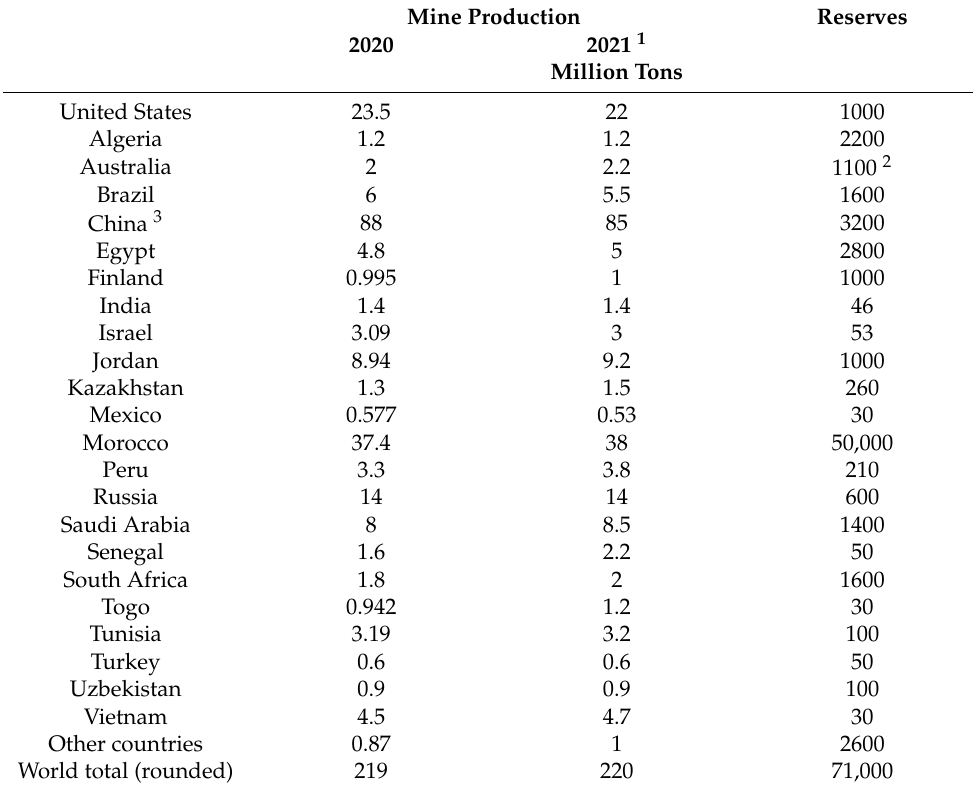
Table 1. World production and reserves of phosphate rocks in 2020–2021 [4]. Mine Production